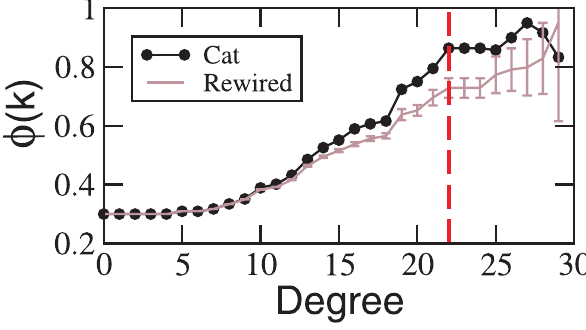
Figure 8. K-density of the corticocortical directed network of the cat w ( k ) , compared to the expectation out of the surrogate ensemble. The largest difference occurs at k ~ 22 (vertically dashed line) giving rise to a Rich-Club composed of eleven cortical areas.